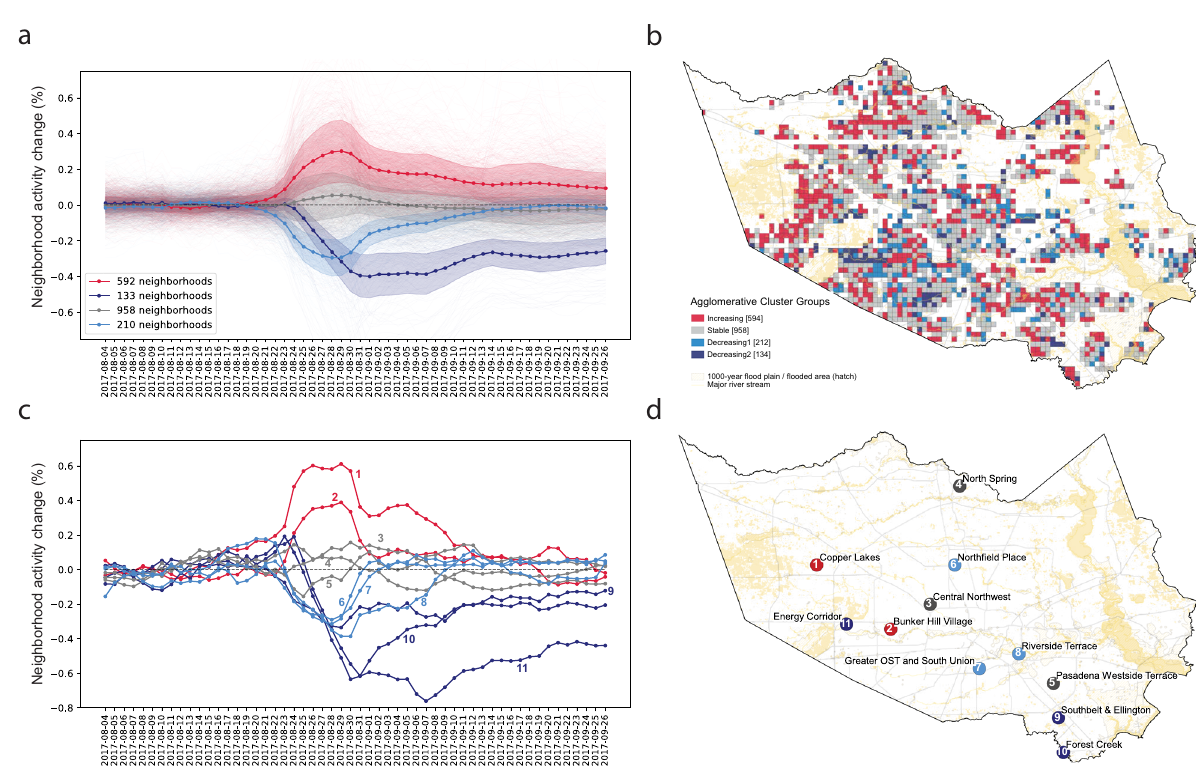
Fig. 1 Distinct neighborhood groups based on disaster response and recovery patterns as identi fi ed by agglomerative clustering. a This time series plot shows community activity level trends over the time period from August 4th through September 26th. The agglomerative clustering algorithm identi fi es four distinct groups that represent similar patterns of disaster response and recovery at the neighborhood level. Plots denote mean activity of each cluster with one standard deviation uncertainty band. b The map shows spatial patterns of identi fi ed clusters. Most dark blue neighborhoods show a signi fi cant decrease in community activities due to devastating fl ooding near reservoir areas. c Illustrative neighborhood activity curves for each cluster group associated with their location in ( d